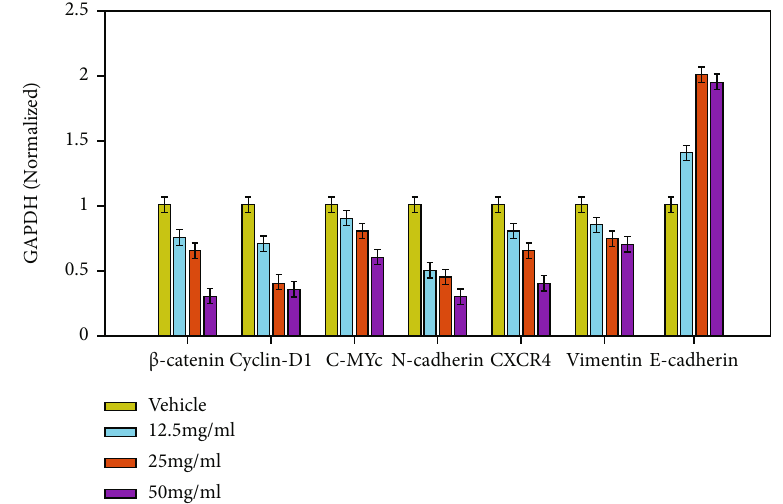
Figure 6: Invasion of HCT116 cells, p < 0 : 05 compared with vehicle.